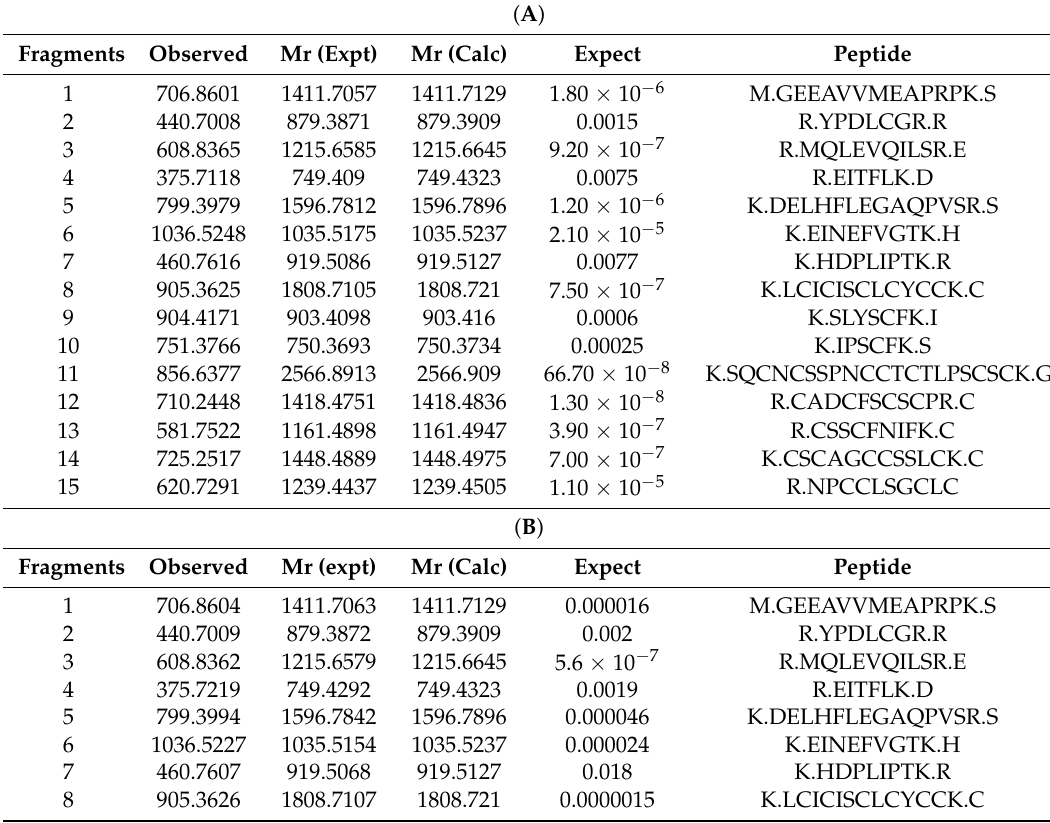
Table 1. LC-MS/MS analysis of G γ 4 fragments in leaf sheath of wild type (WT) and Dn1-1. ( A ) G γ 4 fragments in immunoprecipitation products of the WT membrane fraction. ( B ) G γ 4 fragments in immunoprecipitation products of the Dn1-1 membrane